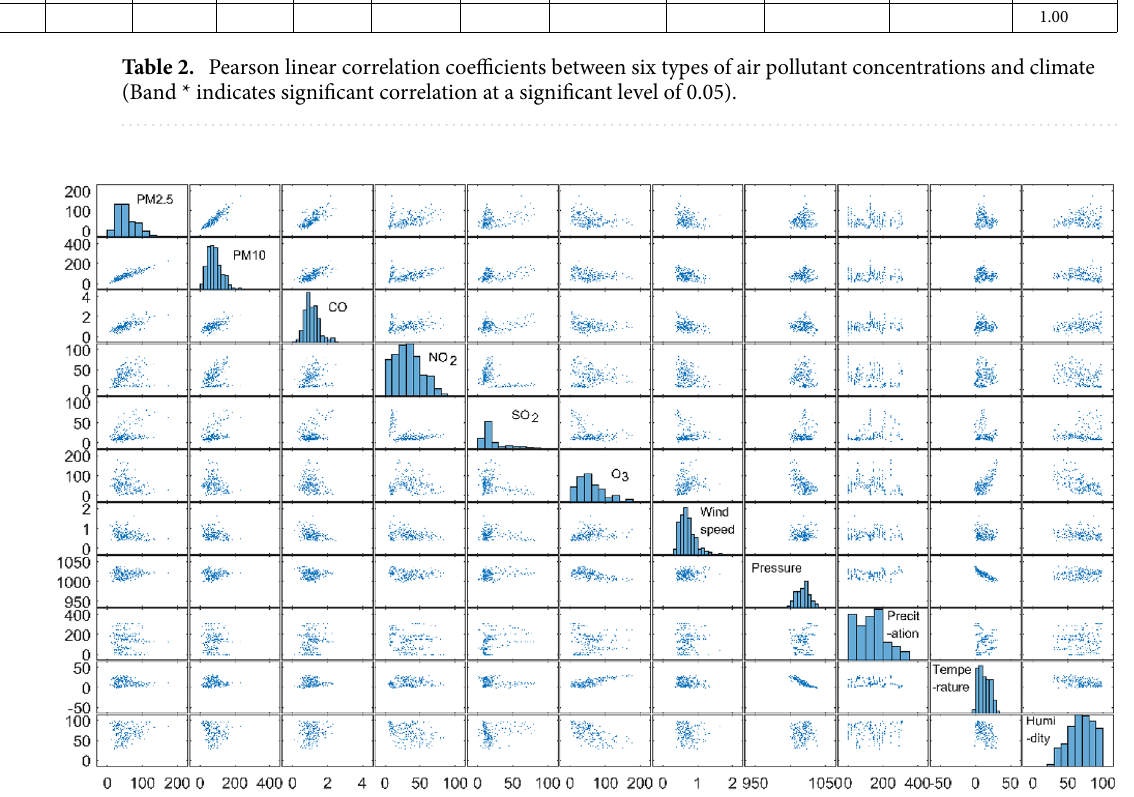
Figure 3. Scatter plot of the variables used for the pollutant concentration prediction model. The graph on the diagonal is the histogram of the frequency distribution of each